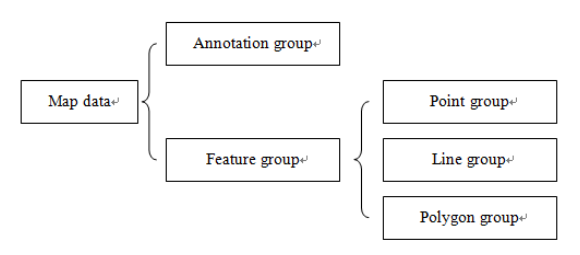
Fig.4 layer group of cartography data